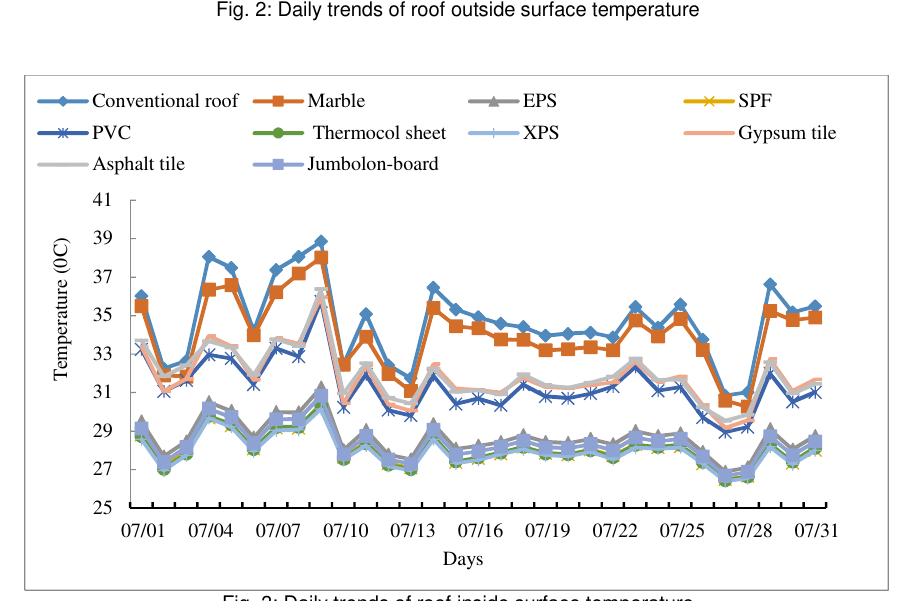
Fig. 3: Daily trends of roof inside surface